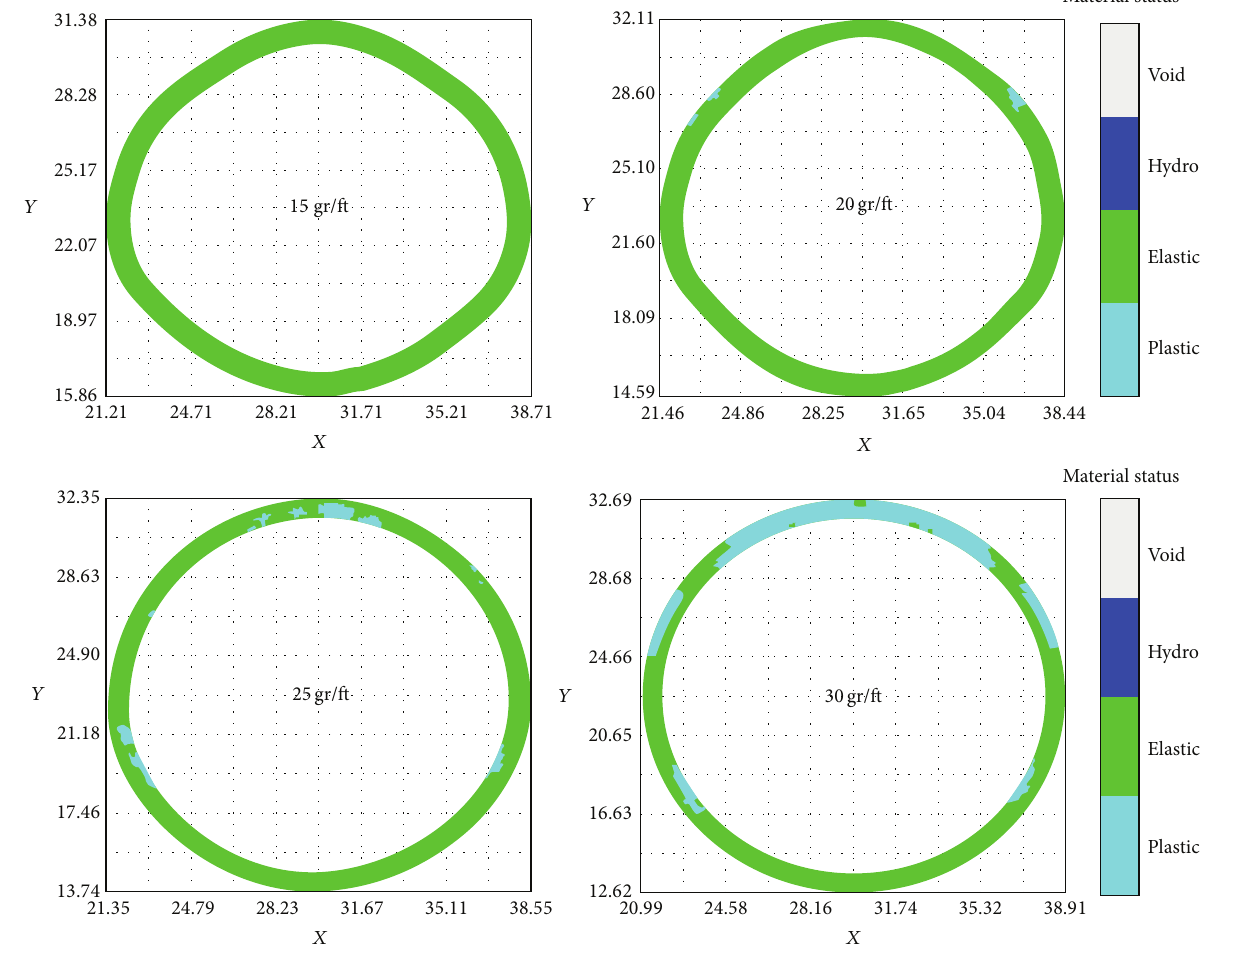
Figure 8: Material status of expanded steel tube.